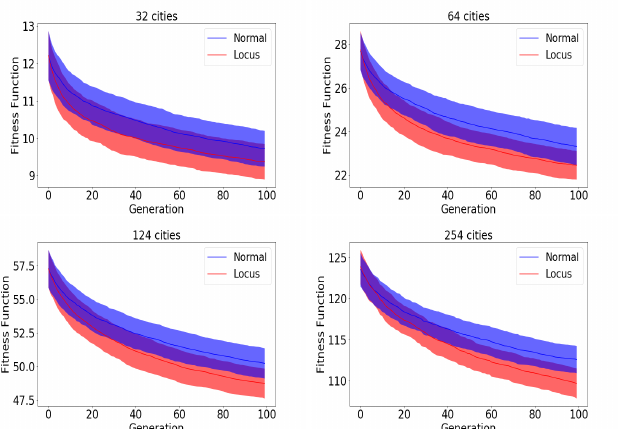
Figure 7. Comparison between Locus mutation and traditional mutation with different sets of parameters. The figures depict TSP problem with 32, 64, 124 and 254 cites. We averaged out the runs with two different generation size [400,600], [400,600], [600,1000] and only 1000 for 254 cities constellation. We only selected the best solution out of these five different values of mutation rate [0.01, 0.1, 0.6, 0.3 and 0.9]. The center of each curve is the expected value while the range visualizes the standard deviation. All the experiments have been repeated 100 times and then averaged out Table 2. TSP optimal solution after 100 generation. Two different population size, 200 and 400, have been investigated with a 100 different repetition. All the runs have been averaged out. IterNum is the number of cities (population number), while MutRate is the mutation